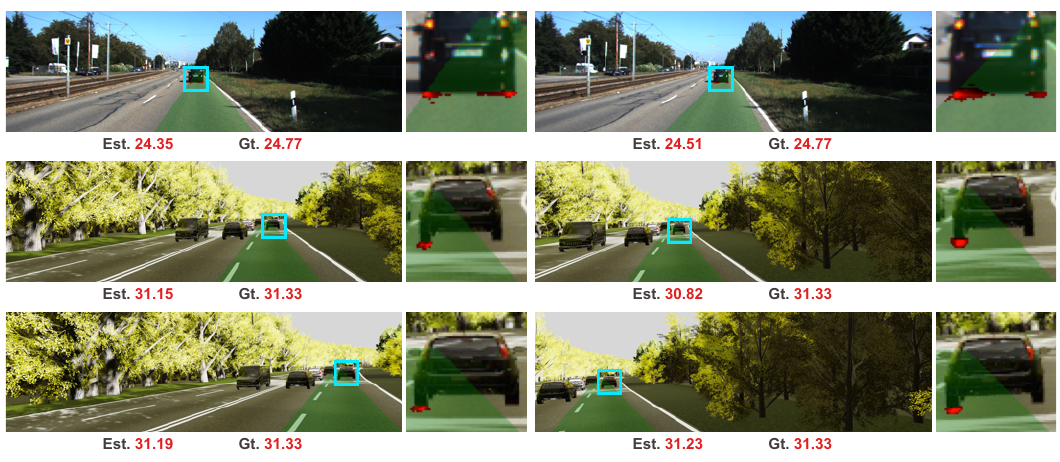
Figure 8. Generalization capability. These six images are from KITTI and virtual KITTI datasets. They are collected with different cameras and views than the training dataset.